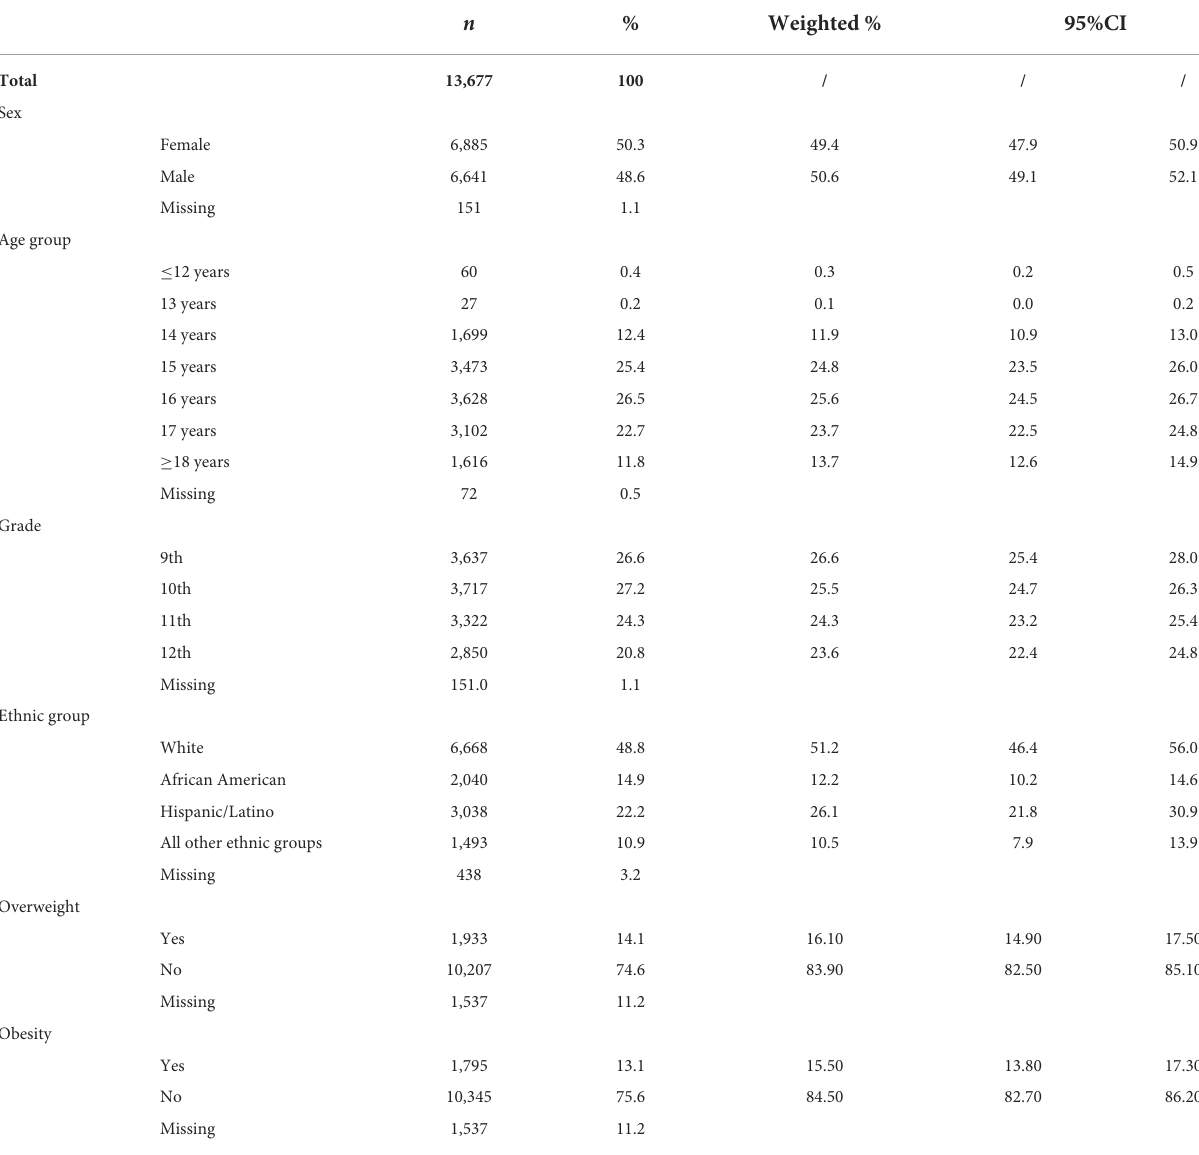
TABLE 1 Demographic characteristics of the